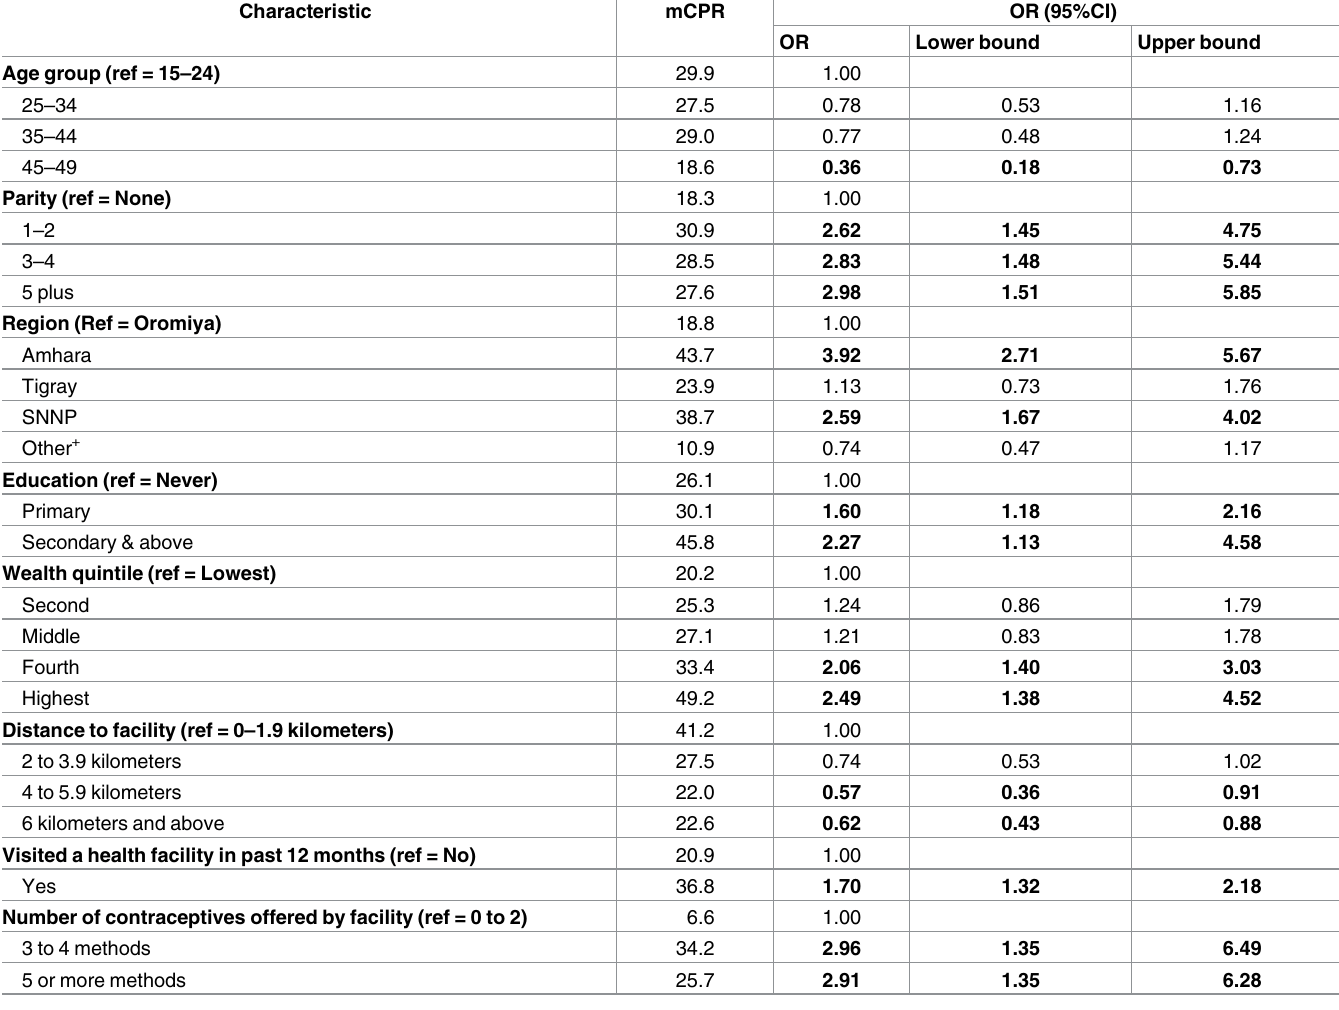
Table 2. Factors influencing contraceptive use—Results from multivariate logistic regression